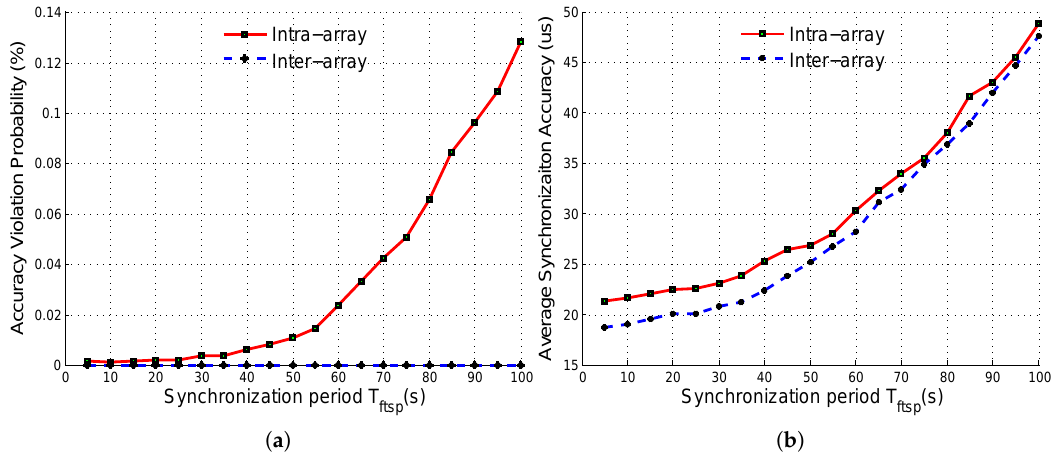
Figure 10. Synchronization metrics when using the Flooding Time Synchronization Protocol (FTSP) protocol. ( a ) accuracy violation probability; ( b ) average synchronization